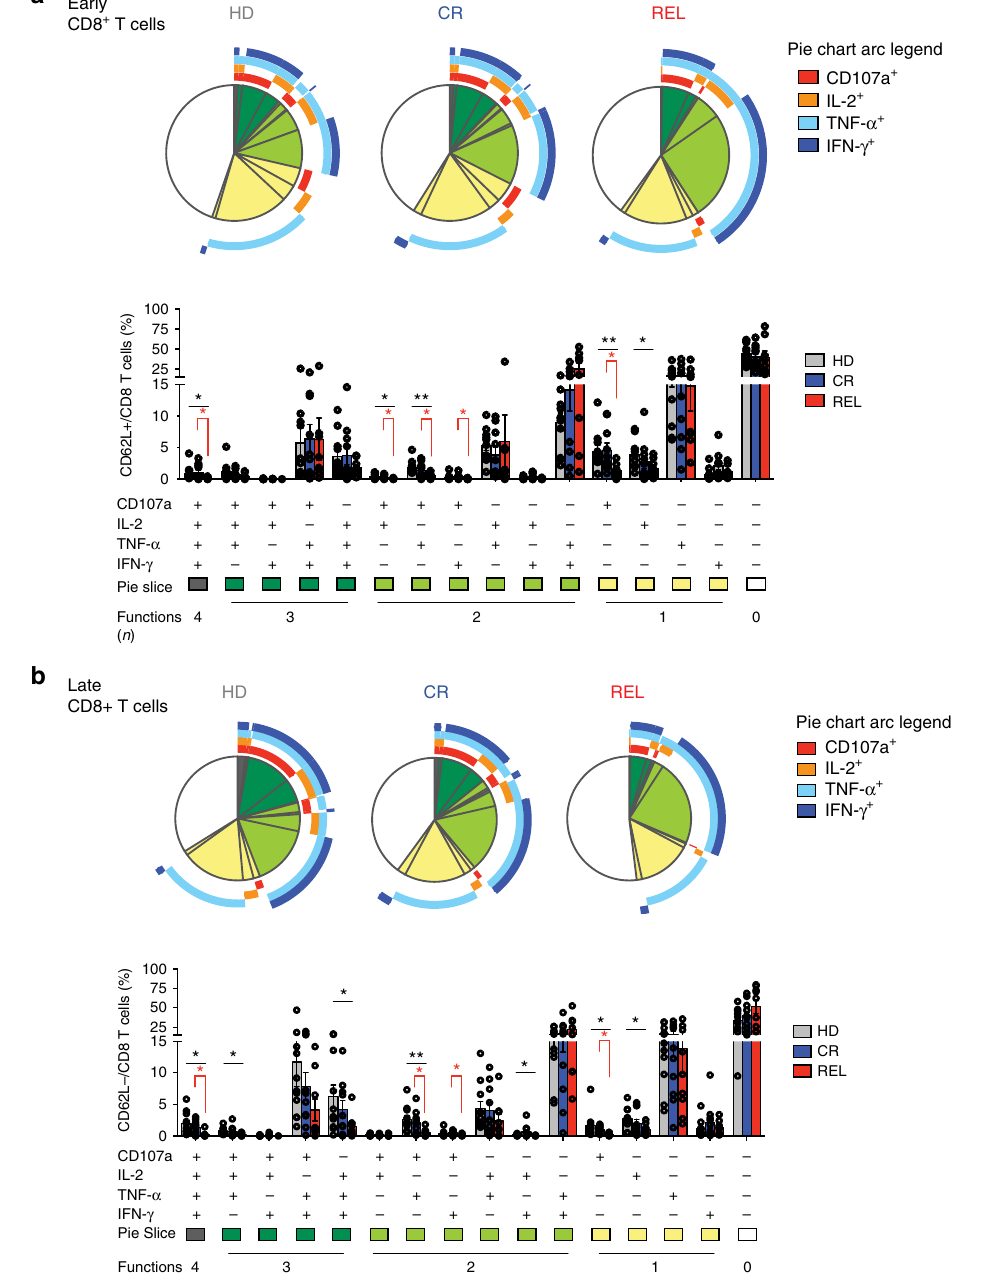
Fig. 4 CD8 + BM-T cells from relapsing patients display defective polyfunctionality. Cytokine production (IL-2, TNF- α , IFN- γ ) and degranulation capacity (CD107a expression) of CD8 + T cells upon PMA/Ionomycin stimulation were evaluated in bone marrow samples. a , b Pie charts with arcs (upper part) and bar chart (lower part) showing the relative proportion of CD8 + T cells performing four, three, or two multiple effector functions or one or no effector functions in early-differentiated (CD62L + , a ) and late differentiated (CD62L − , b ) subsets. Healthy donors (HD, N = 10), HLA-matched patients maintaining complete remission (CR, N = 10) or relapsing after transplant (REL, N = 10) were evaluated. Arcs represent which function was exerted, alone or in combination with the others (CD107a, IL-2, TNF- α , and IFN- γ ). Individual patient data points, means, and SEM are shown. Statistically signi fi cant differences between CR and REL groups are highlighted in red and the differences between patients ’ groups and HD in black. * p < 0.05; ** p < 0.01; *** p < 0.001; **** p < 0.0001, nonparametric unpaired two-sided T